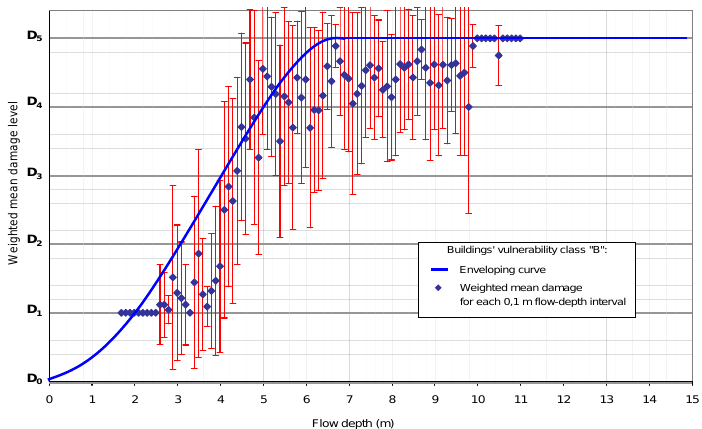
Fig. 5. Histogram showing the distribution data for building vulnerability class “B”. Each colour represents a damage state “ Dj ”, j = 1 to 5. (“ D 0=No damage”, “ D 1=Light damage”, “ D 2=Moderate damage”, “ D 3=Important damage”, “ D 4=Heavy damage”, “ D 5=Collapse”).